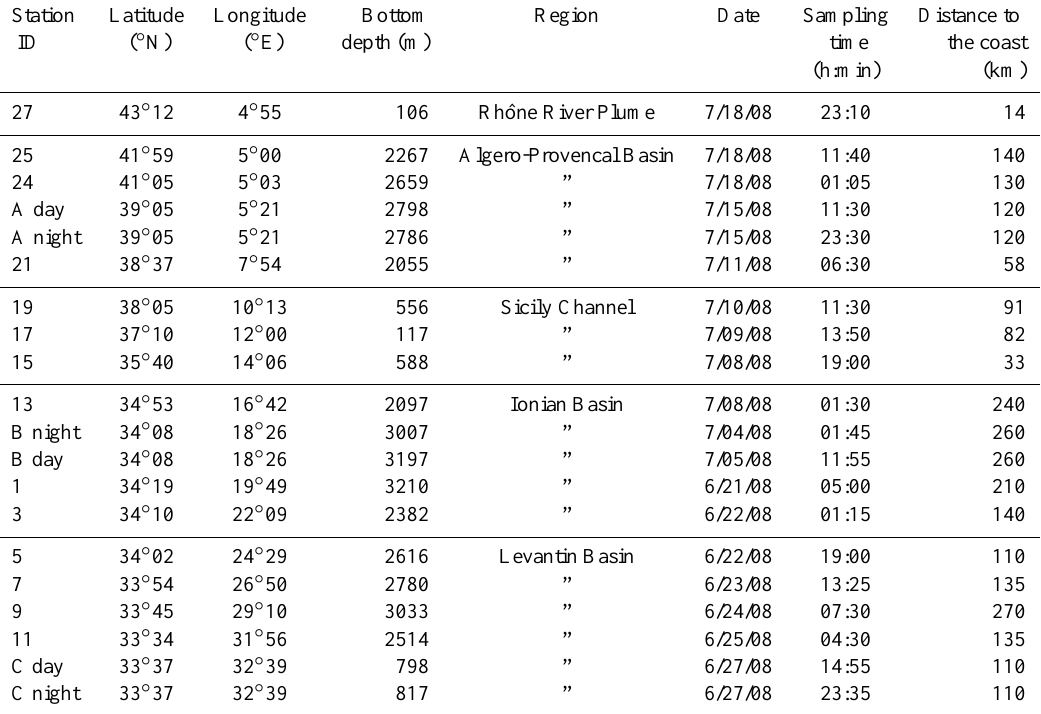
Table 1. Position and characteristics (latitude, longitude, bottom depth, geographical region, date, sampling time and shortest distance to the coast) of the zooplankton sampling stations during the BOUM